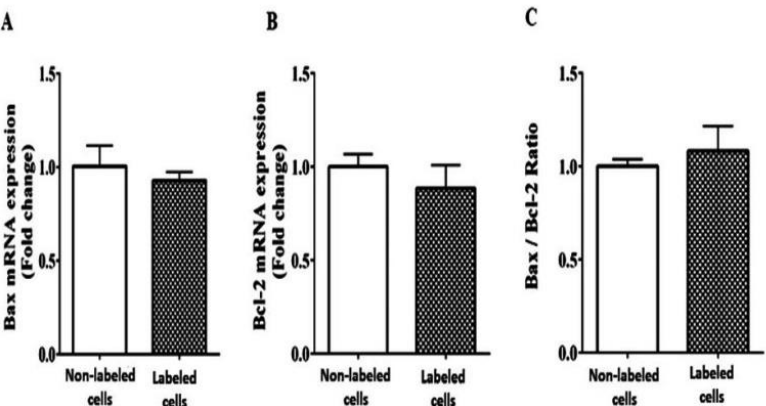
Figure 7. The effect of 180 µg/mL of iron oxide transfected with 1 µL/mL of lipofectamine on gene expression of Bax pro-apoptotic gene ( A ), Bcl-2 anti-apoptotic genes ( B ), and Bax/Bcl-2 ratio ( C ) of labeled DPSCs (Bcl-2: p = 0.41 , Bax: p = 0.38, and Bax/Bcl-2 ratio: p = 0.58), revealing that 180 µg/mL of iron oxide transfected with 1 µL/mL lipofectamine in labeled DPSCs did not induce any significant apoptosis when used in cell labeling.